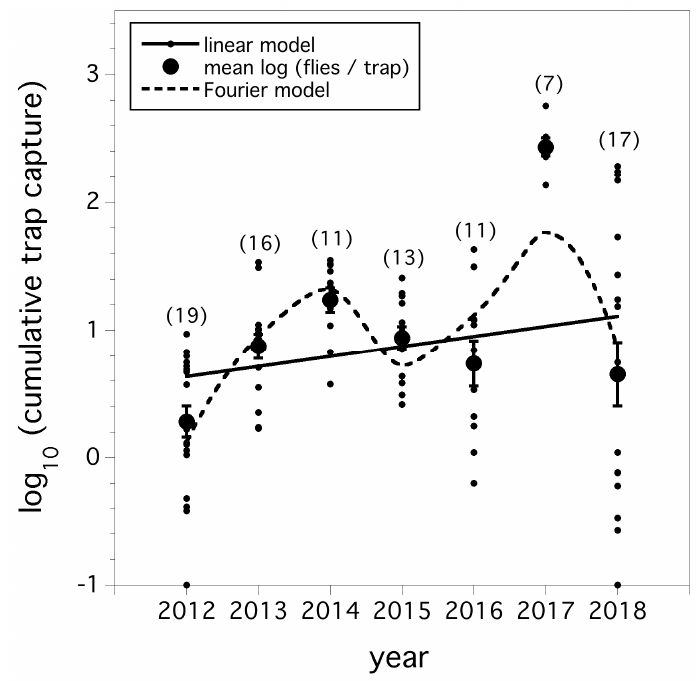
Figure 1. Cumulative trap captures (logarithm transformed) of D. suzukii at a standardized growing season of 705 DD (base 10 ◦ C). Small filled circles are individual field captures and large filled circles are annual means (error bars are standard errors). Parentheses above each year are the number of fields where degree-day information was available (total n = 97). Solid line is linear model and dashed line is Fourier periodic model. Insects 2019 , 10 , x FOR PEER REVIEW